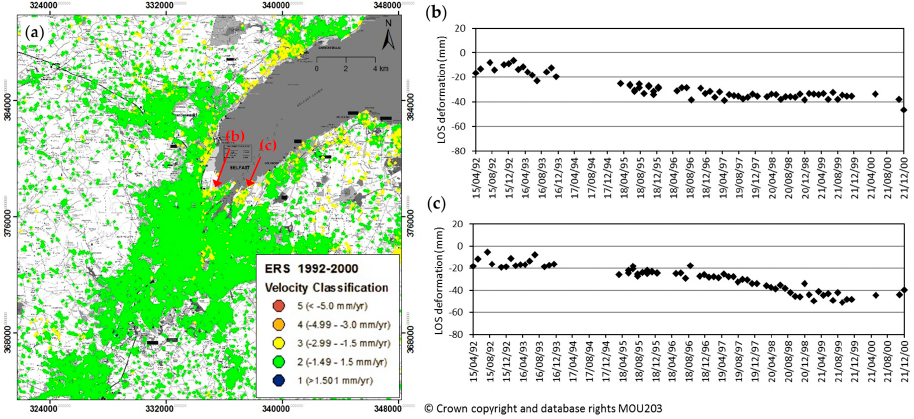
Table 6. Reference summary geology for the Belfast